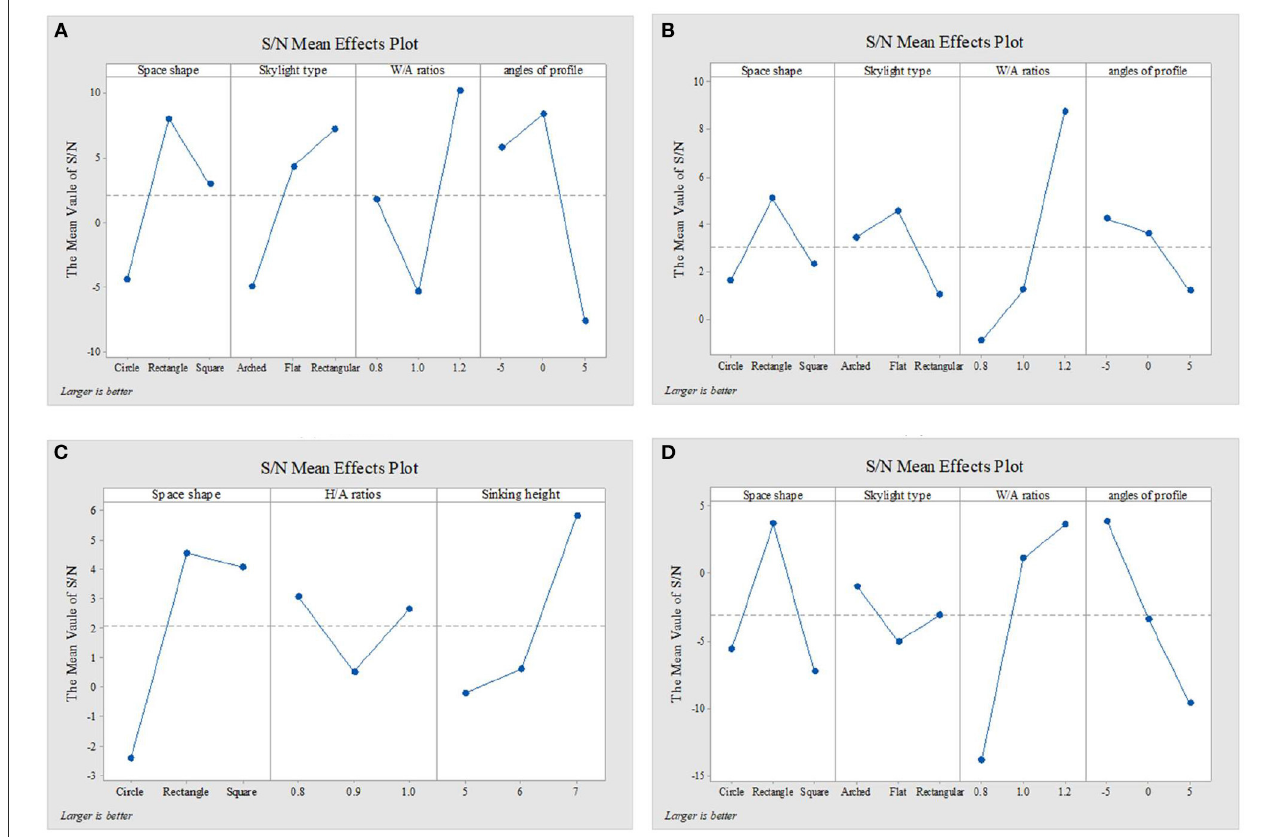
FIGURE8 Physical environment response values for (A) TUAI, (B) TCAI, (C) TCSI, and (D) THAI. Image source: self-drawn by the author.